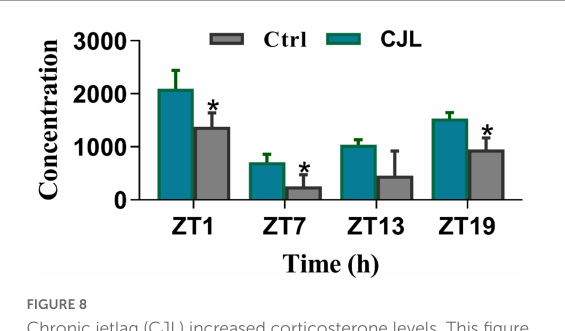
FIGURE8 Chronic jetlag (CJL) increased corticosterone levels. This figure shows the plasma total corticosterone in C57/BL6 mice treated with phase advance CJL for 30 days, on four different time points (ZT1, ZT7, ZT13, and ZT19). Total corticosterone in a sample of tail blood was measured. All data are presented as means ± SEM, * P < 0.05, ** P < 0.01, student’s t -test ( n =